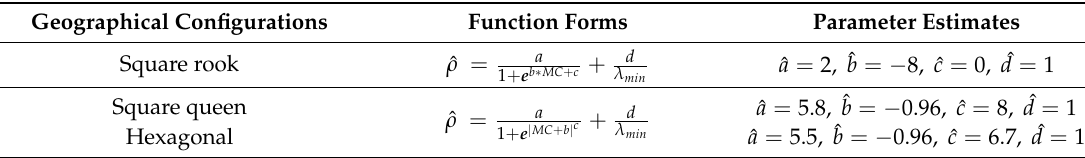
Table 1. Theoretical functions for 𝜌 versus the Moran coefficient (MC).